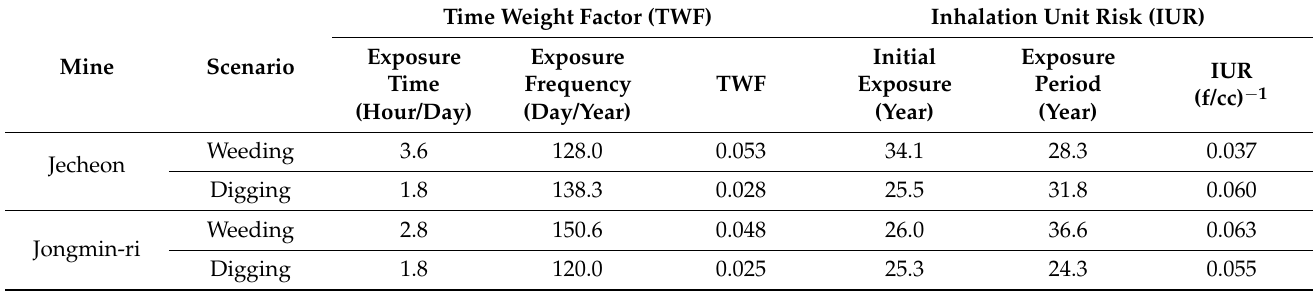
Table 2. Scenarios of the modified RAS and TWF and ELCR value for the Jecheon and Jongmin- ri